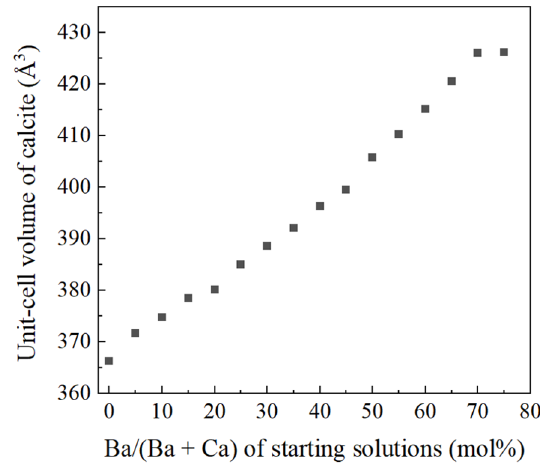
Figure 4. Unit-cell volume of calcite samples obtained from heating treatment vs Ba / (Ba + Ca) ratio of starting solutions.